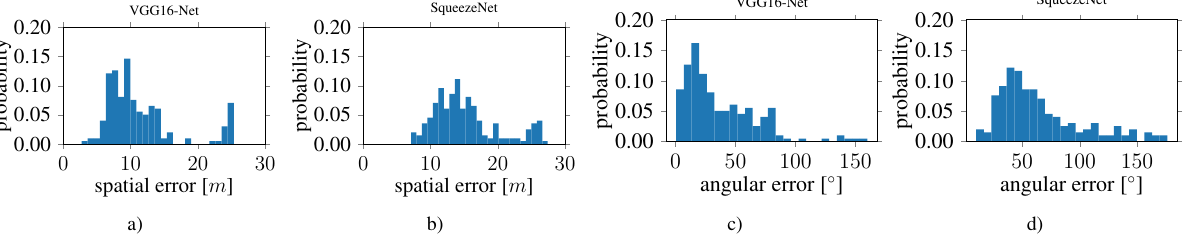
Figure 9. Low coverage sequence . The histograms show the spatial and angular errors of the CNN derived poses to ground truth. Whereas a) and b) depict the spatial errors of the VGG16-Net respectively SqueezePoseNet and c) and d) the angular